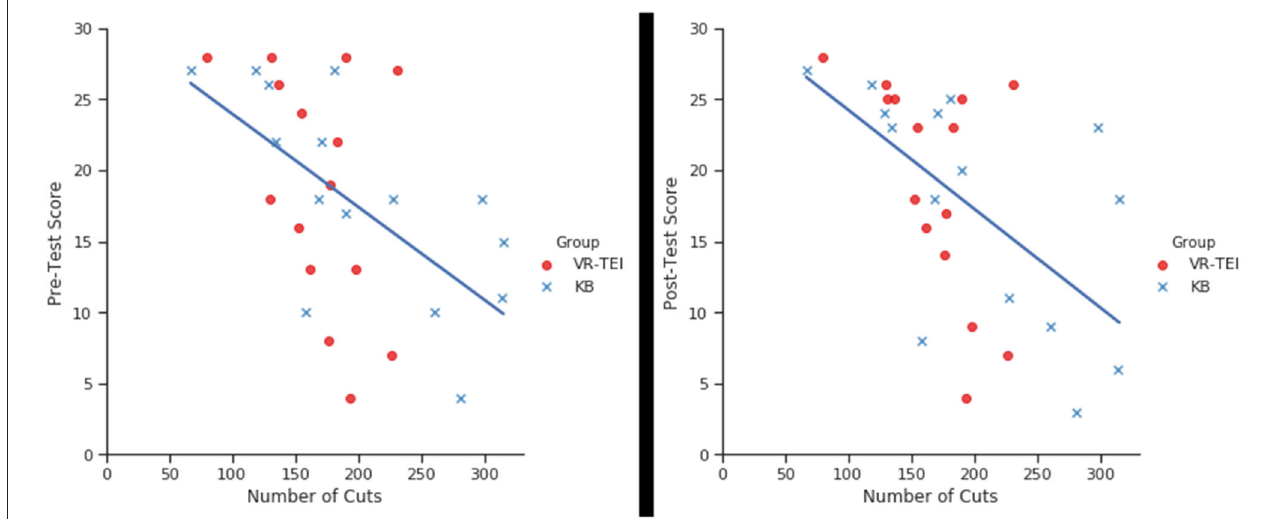
FIGURE 4 | Correlation graphs displaying the relationship between number of cuts and pre- and post-test SBST scores in the study.